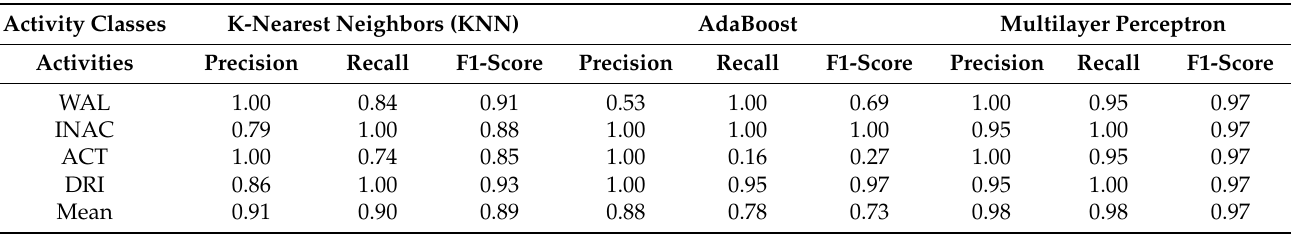
Table 5. Performance comparison of multilayer perceptron classifier with KNN and AdaBoost classifiers on Real-Life HAR in terms of precision, recall, and